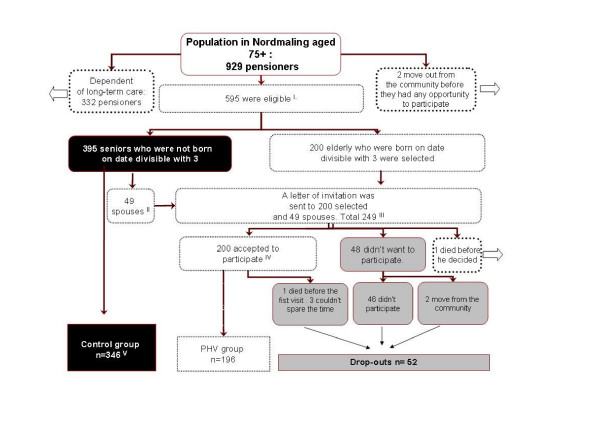
Description of the studied population.